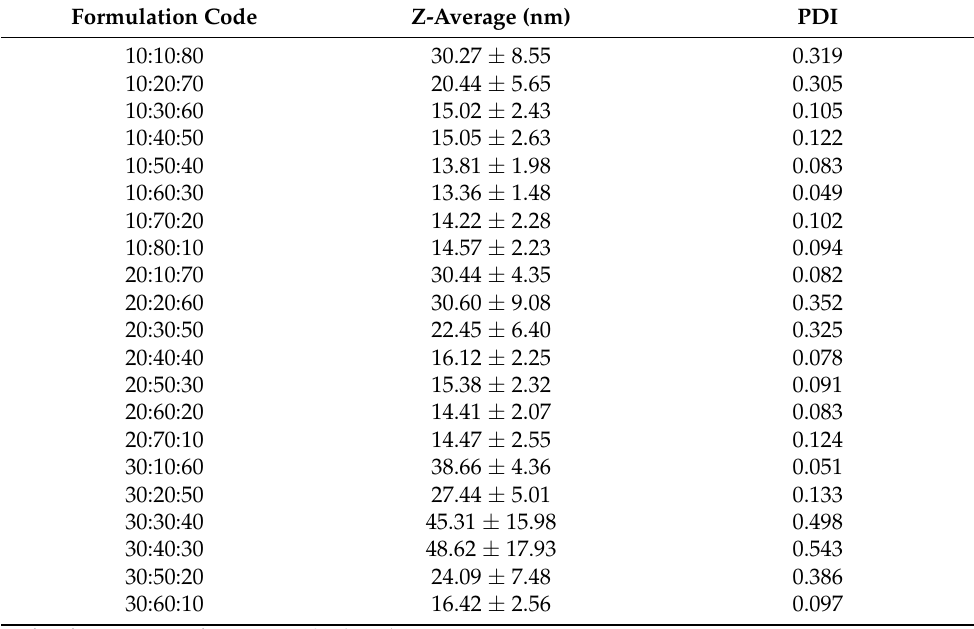
Table 4. Z-average and PDI values of blank formulations up to 30% Imwitor ® 988. Formulation